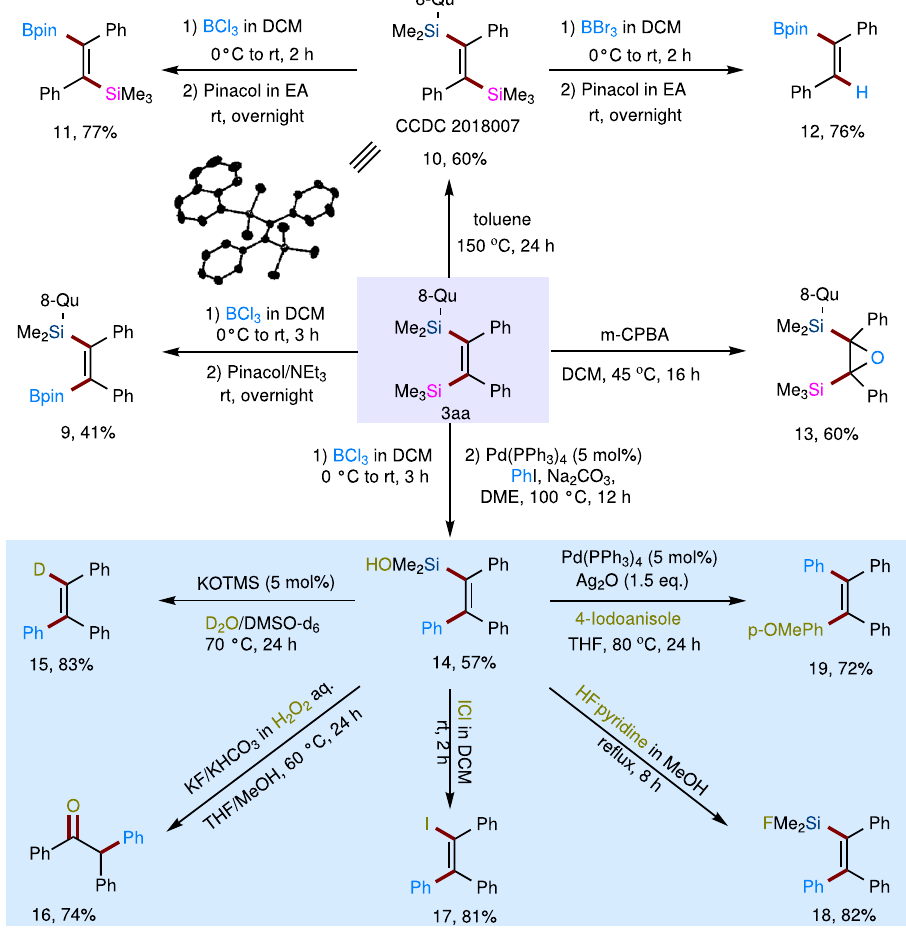
Fig. 6 Synthetic utilities of product 3aa. The product 3aa resulting from bis-silylation can be conveniently transformed to a variety of skeletons by programmable sequential synthesis. Yields are for isolated and puri fi ed products. The detailed procedures for these downstream transformations have been presented in Supplementary Information